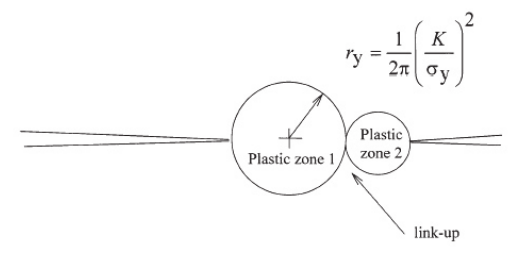
Figure 6: Swift criterion for